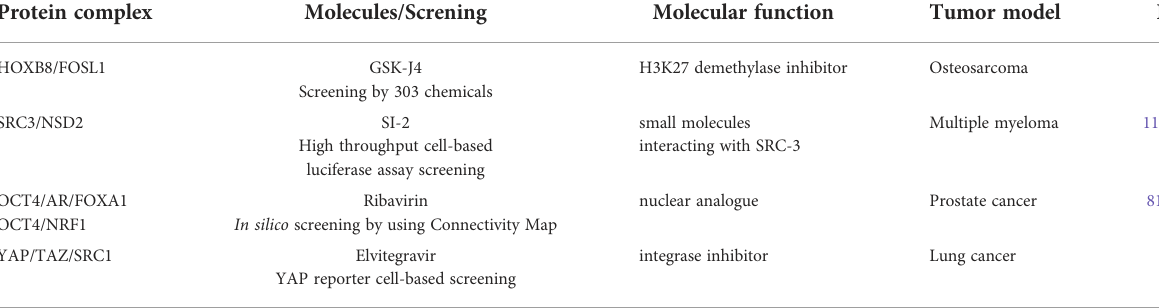
TABLE 2 Summary of molecules for targeting phase-separation for treating treatment-resistant malignancy. Protein